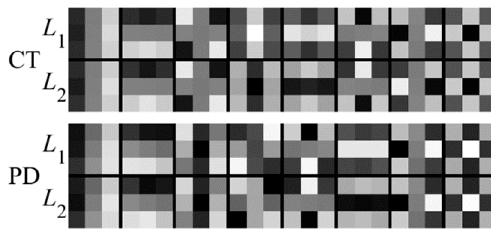
Figure 13. Filters learned for the multiple layers by the PCANet. The first and second rows are the filters at the first and second stages for the CT images, respectively; the third and fourth rows are the filters at the first and second stages for the PD images, respectively.